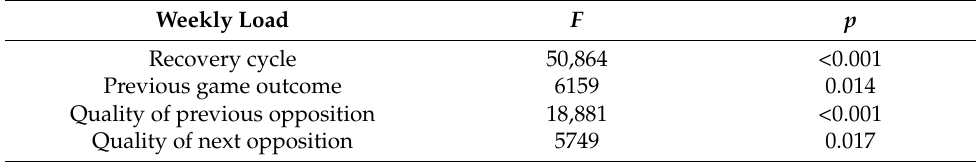
Table 2. Main significant effects on weekly load.